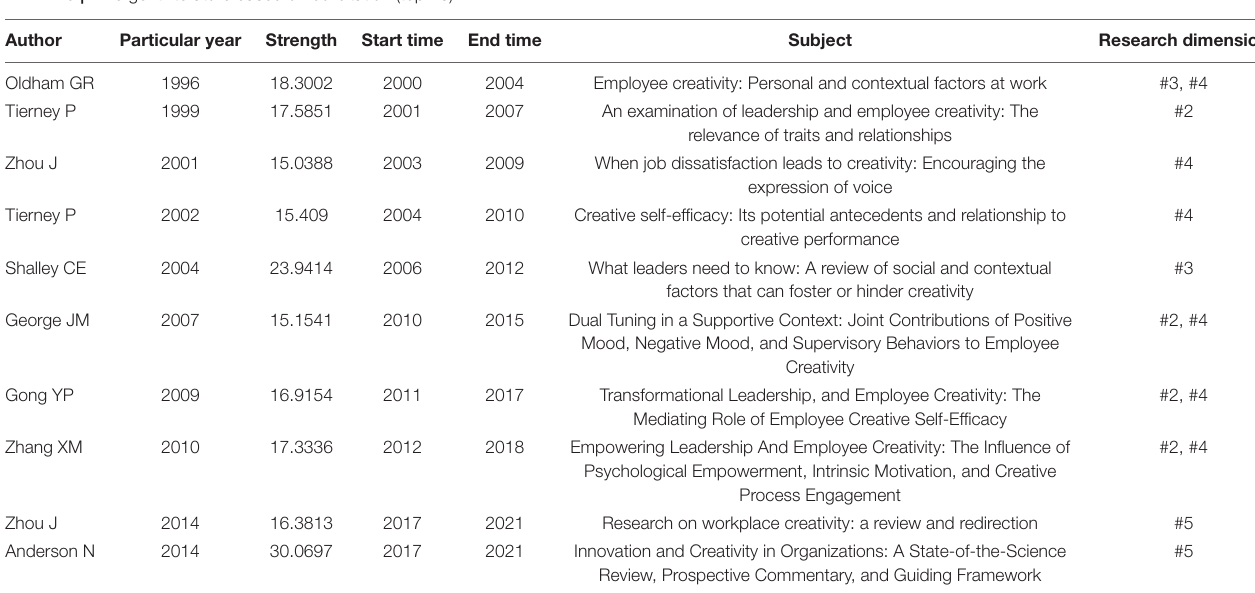
TABLE 3 | Emergent literature based on co-citation (top 10).